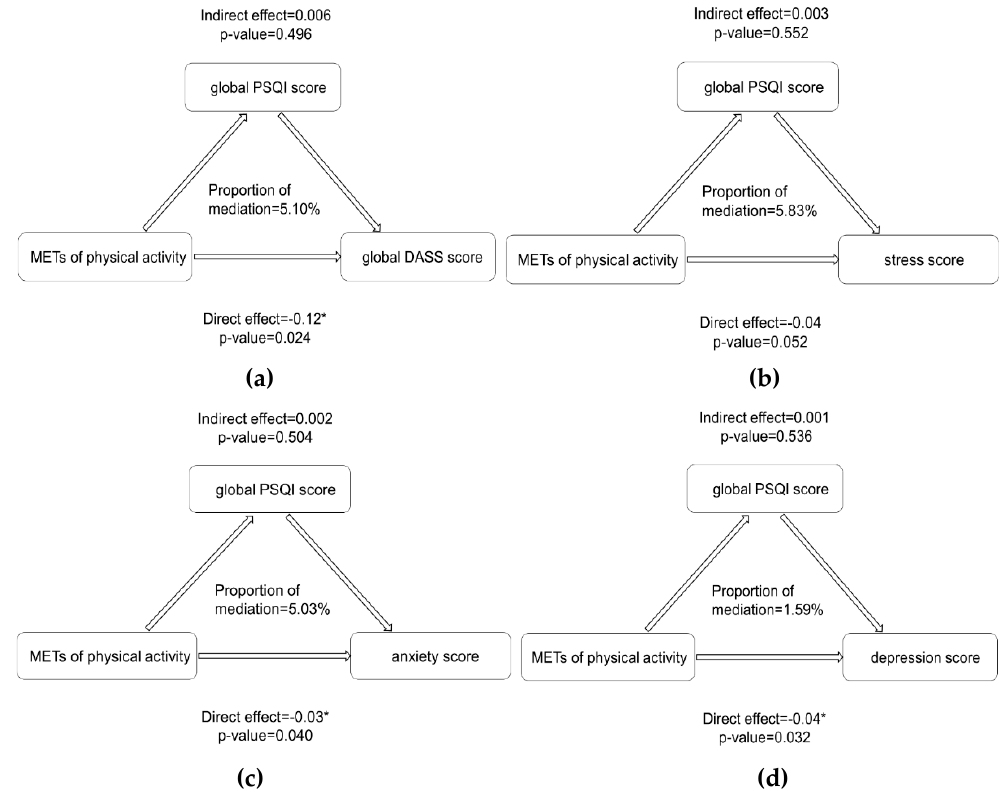
Figure 3. Mediation effects of sleep quality on the relationship between physical activity and negative emotions. Note: The subgraph of ( a – d ) indicates the direct influencing path of the physical activity on global negative emotions, stress, anxiety and depression, respectively, without sleep quality playing as a mediator. Asterisks indicate significance at the 5% level. So, no mediation effects were significant in this figure. MET: the ratio of work metabolic rate to a standard resting metabolic rate. METs: energy expenditure in MET-minutes per week; PSQI: Pittsburgh Sleep Quality Index .